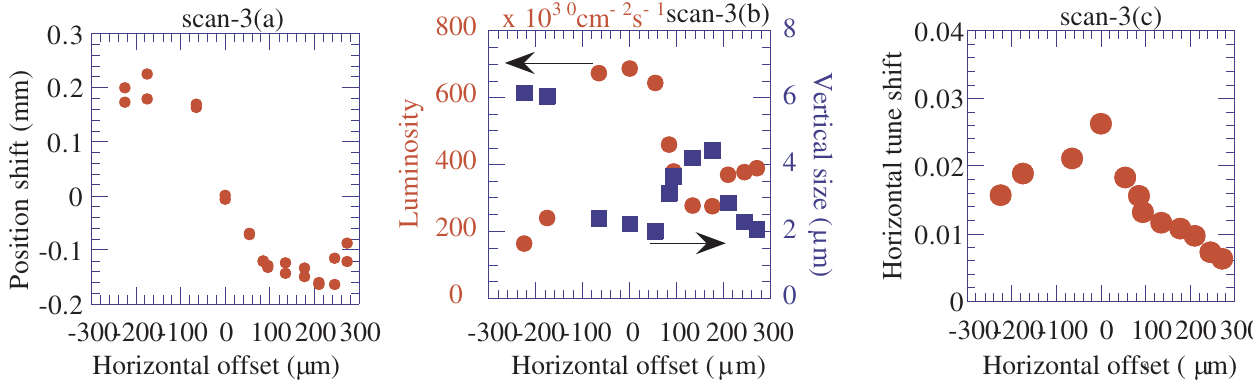
FIG. 8. (Color) Variations of the beam parameters as a function of the horizontal offset with the beam condition of scan-3 (a wide bunch spacing of 47.2 ns). Position shift at LER-2 (a), luminosity (red dots) and vertical beam size of the positron beam at the IP (blue squares) (b), and horizontal beam-beam tune shift